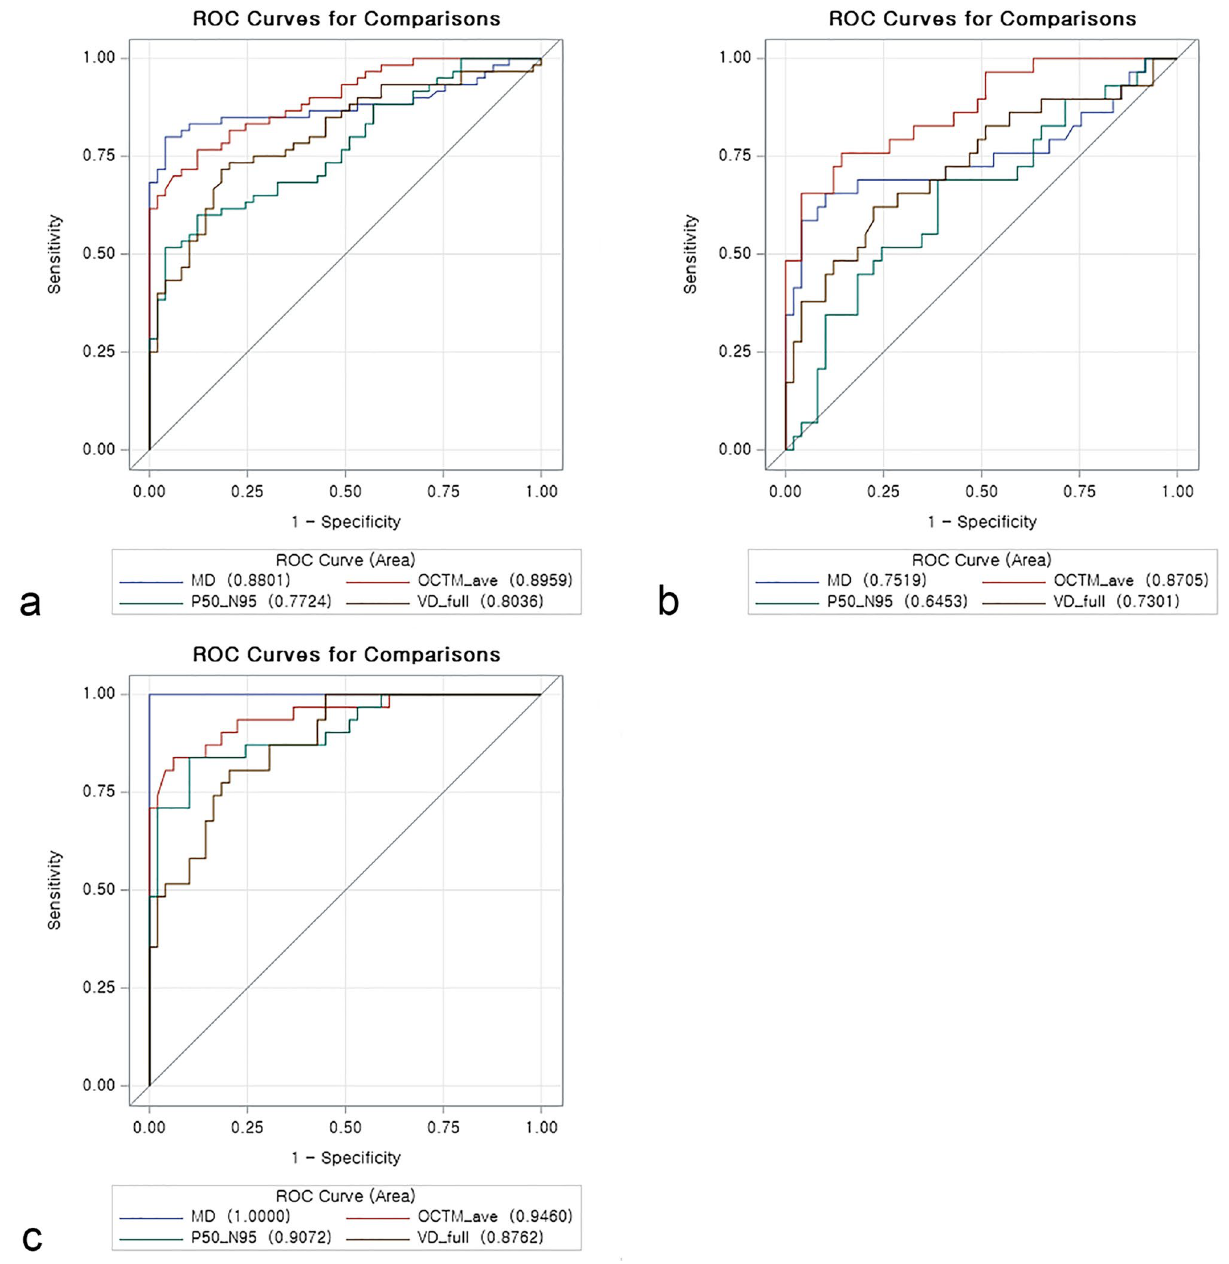
Figure 1. Age-adjusted receiver operating characteristic curves of MD, Ganglion cell-inner plexiform layer average thickness, the amplitude of P50–N95, and macular VD for the detection of glaucoma ( a ), early glaucoma ( b ), and moderate to severe glaucoma ( c ). MD mean deviation, OCTM_ave Ganglion cell-inner plexiform layer average thickness, P50–N95 the amplitude of P50–N95, VD vessel